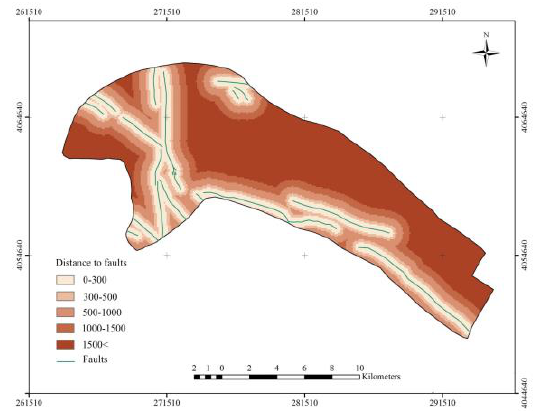
Figure 7. The existing faults in the study area and their hazardous zones (The unit of distance is